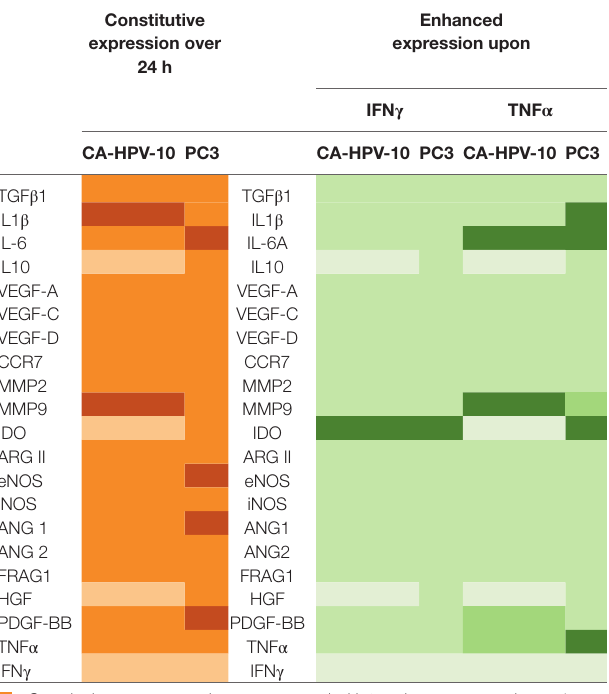
TaBle 2 | Constitutive and cytokine-stimulated expression of genes encoding tumor-derived soluble factors involved in prostate cancer (PCa) progression (33). constitutive expression